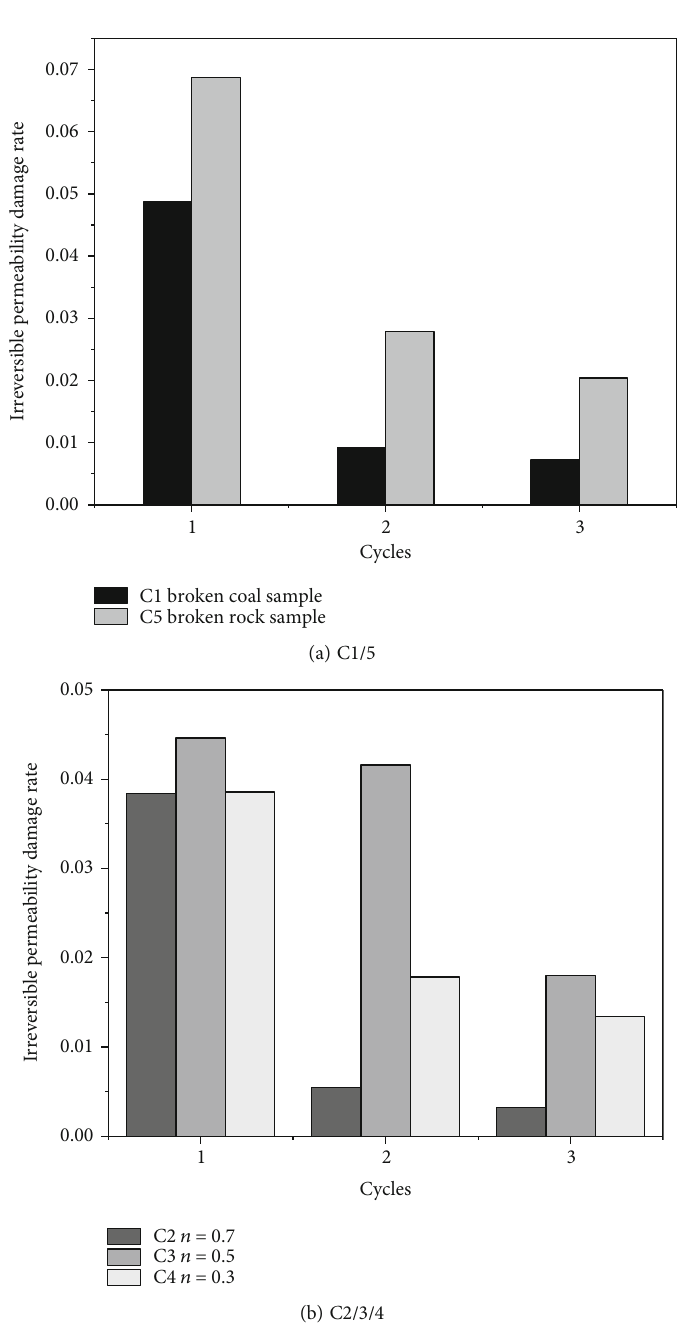
Figure 11: Irreversible permeability loss rate of C1 ~ 5 during three loading and unloading